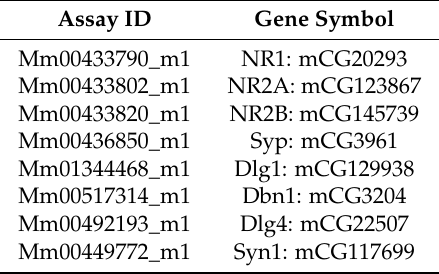
Table 4. TaqMan Assay IDs for real-time polymerase chain reaction